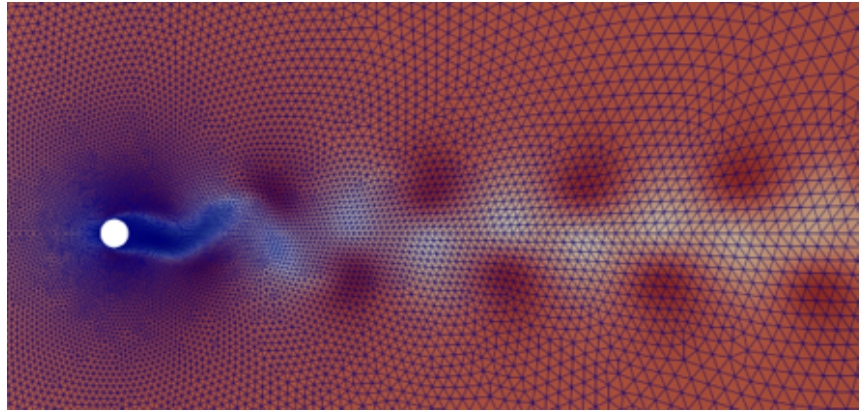
Figure 2. An instantaneous velocity (the horizontal component) of a 2D Karman vortex street